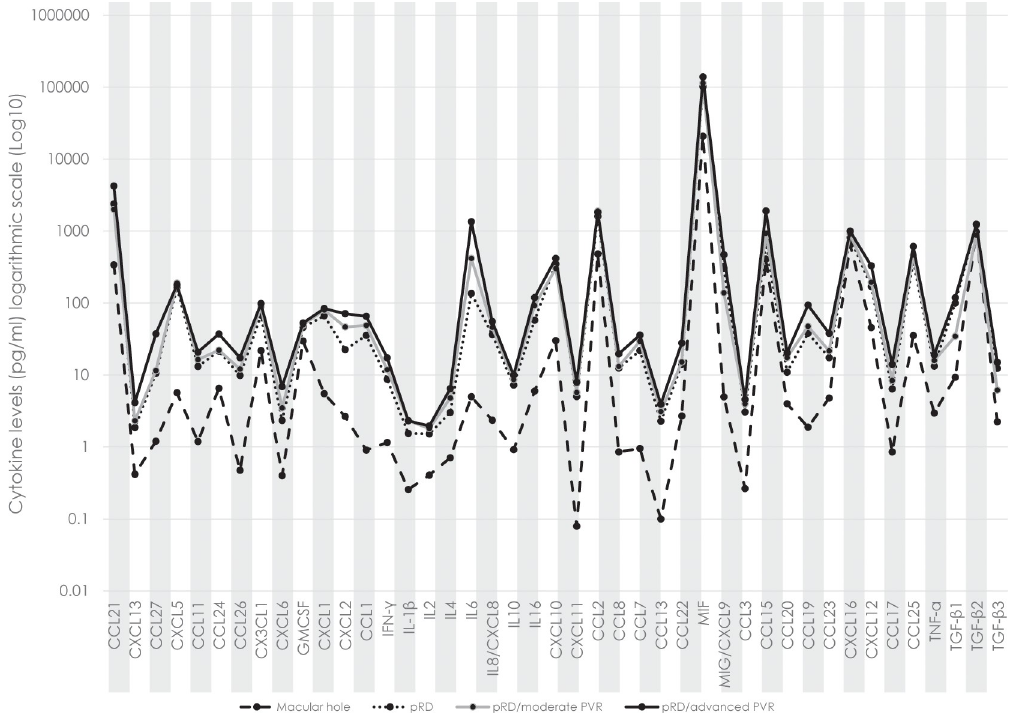
Fig 2. Cytokine levels in the vitreous fluid. Comparing cytokine levels in the vitreous (VF) of eyes of patients with primary retinal detachment without PVR (pRD; n = 81 ) with moderate PVR ( n = 49 ), with advanced PVR ( n = 44 ), and eyes with macular